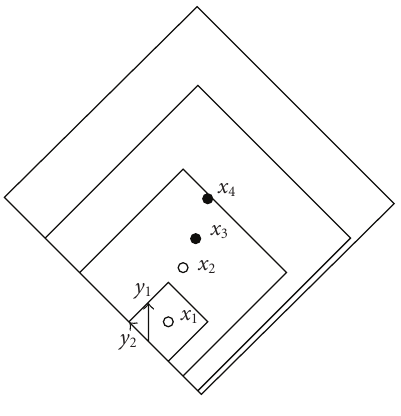
Figure 3.5. Blowing up and shifting a sequence of